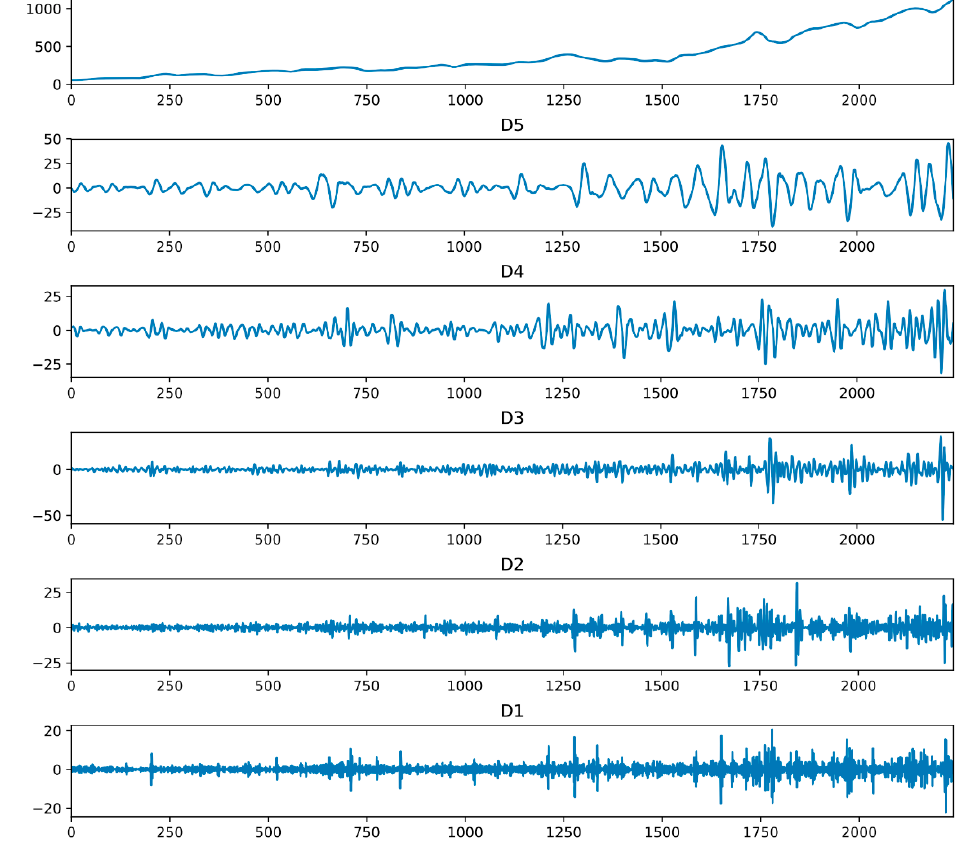
Figure 5. Multi-scale analysis for day closing price (PRC).